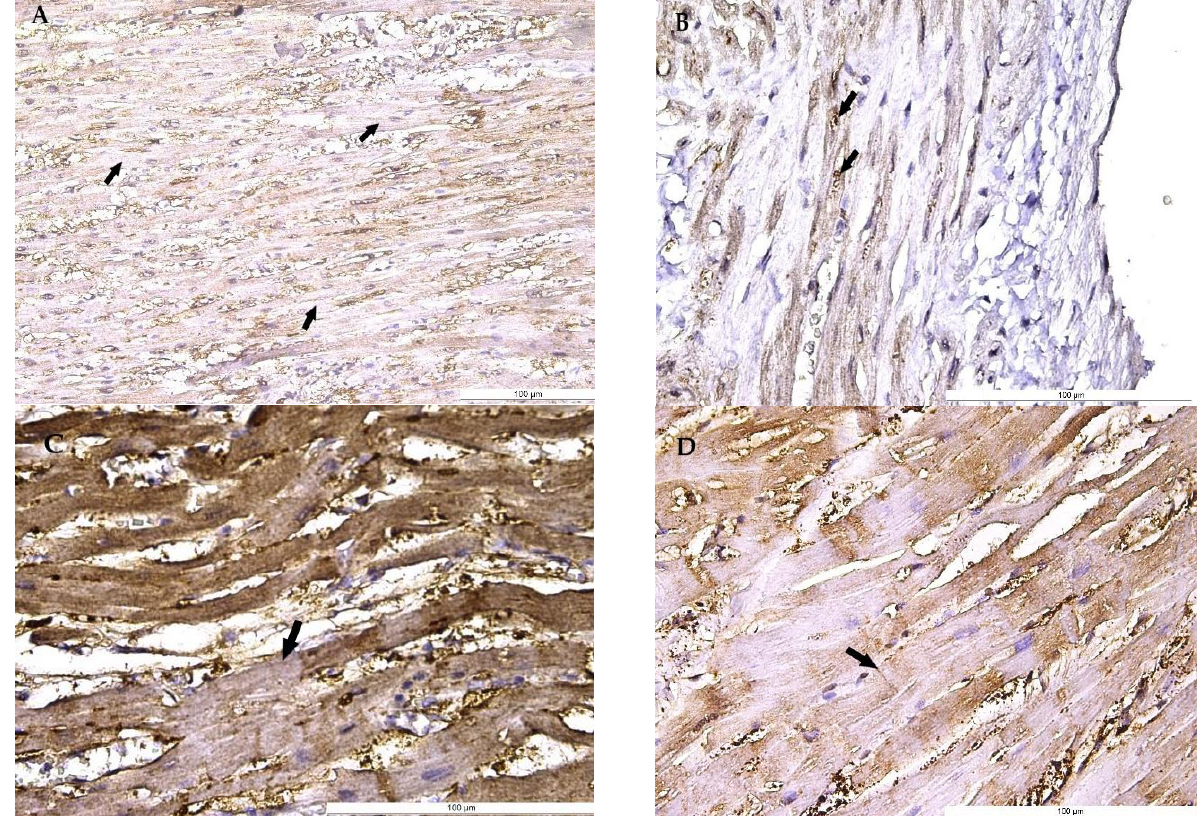
Figure 2. Sirtuin1 (SIRT1) expression in the myocardium of hypothermia cases. ( A ) Nuclear SIRT1 strong positivity along with weak cytoplasmic positivity of cardiomyocytes (arrows). ( B ) Nuclear SIRT1 strong positivity (arrows) along with weak cytoplasmic positivity in myocardial cells. ( C ) SIRT1 positivity in wavy cardiomyocytes, with focal loss of expression (arrow). ( D ) SIRT1 positivity in cardiomyocytes, with focal positivity loss associated with contraction bands (arrow), evident in longitudinal incidences.